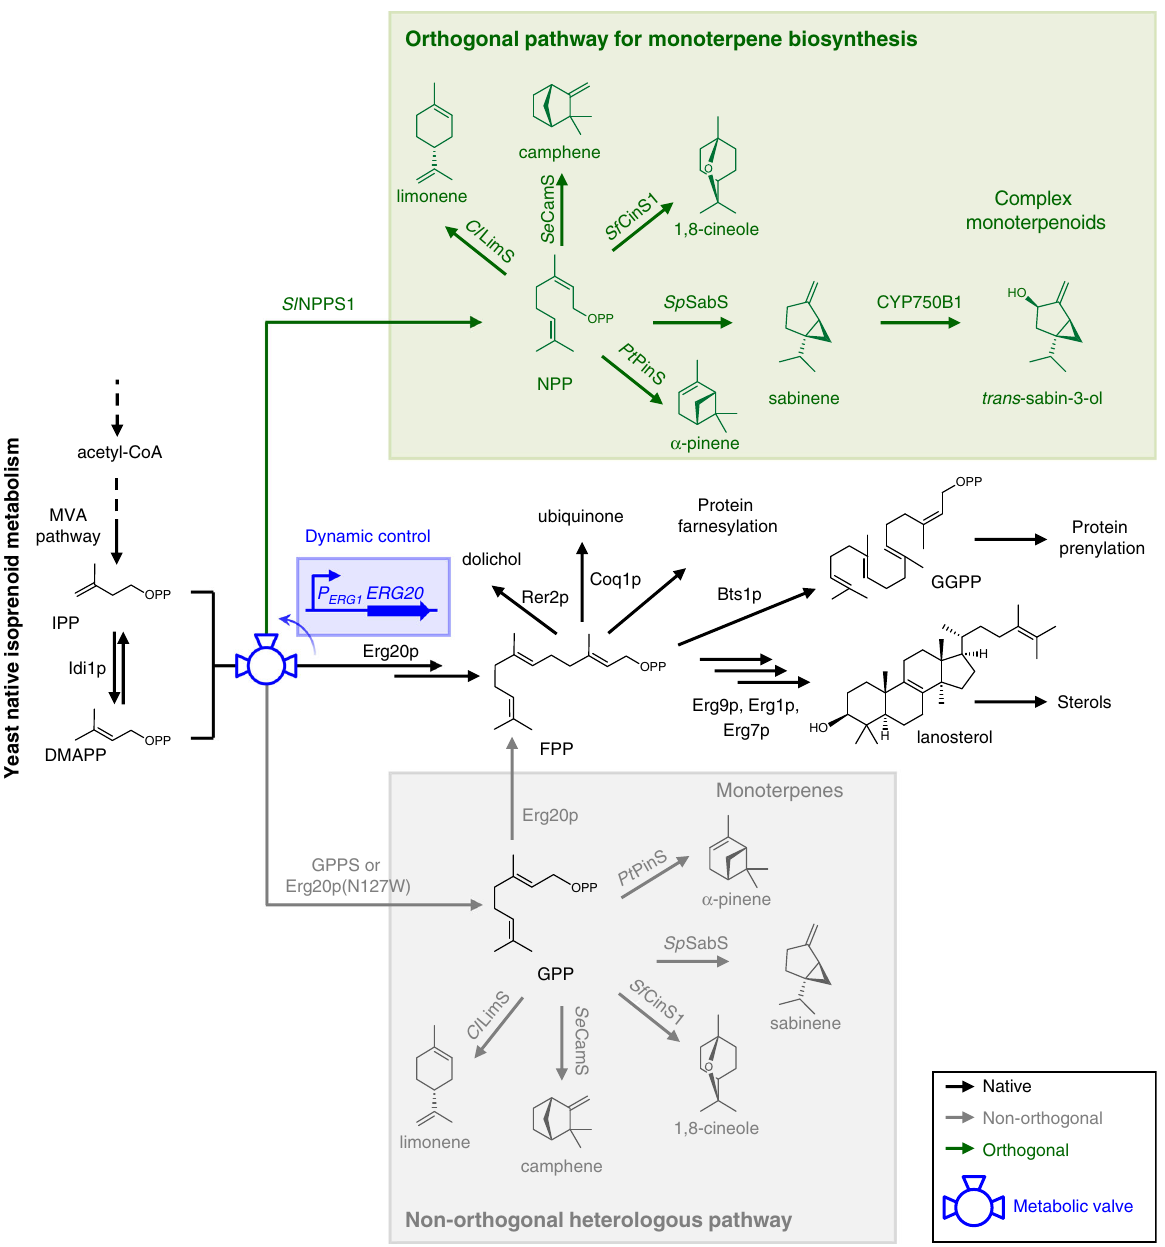
Fig. 1 Engineering an orthogonal monoterpene biosynthetic pathway in yeast. The native yeast isoprenoid biosynthesis includes pathways responsible for the synthesis of sterols, dolichols, ubiquinone, as well as protein prenylation. Production of monoterpenoids in yeast has so far been based on utilizing the GPP synthesized as an intermediate in primary isoprenoid metabolism. This GPP-based non-orthogonal pathway (shown in gray) connects back to primary metabolism through the Erg20p-catalyzed conversion of GPP to FPP. Expression of Sl NPPS1 in yeast cells enables the synthesis of the cis -isomer of GPP, NPP, which cannot be converted to FPP and links back to the biosynthesis of yeast isoprenoids. NPP can be utilized by engineered monoterpene synthases to produce different monoterpenes. The NPP-based pathway, depicted in green, is orthogonal to the yeast metabolism, because it branches out